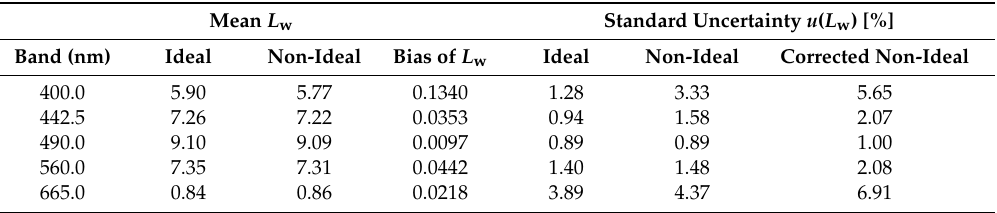
Table 3. The mean and standard uncertainty as a percentage of the mean of water-leaving radiance L w [mWm − 2 nm − 1 sr − 1 ] presented for the ideal and non-ideal cases. Reproduced with permission from